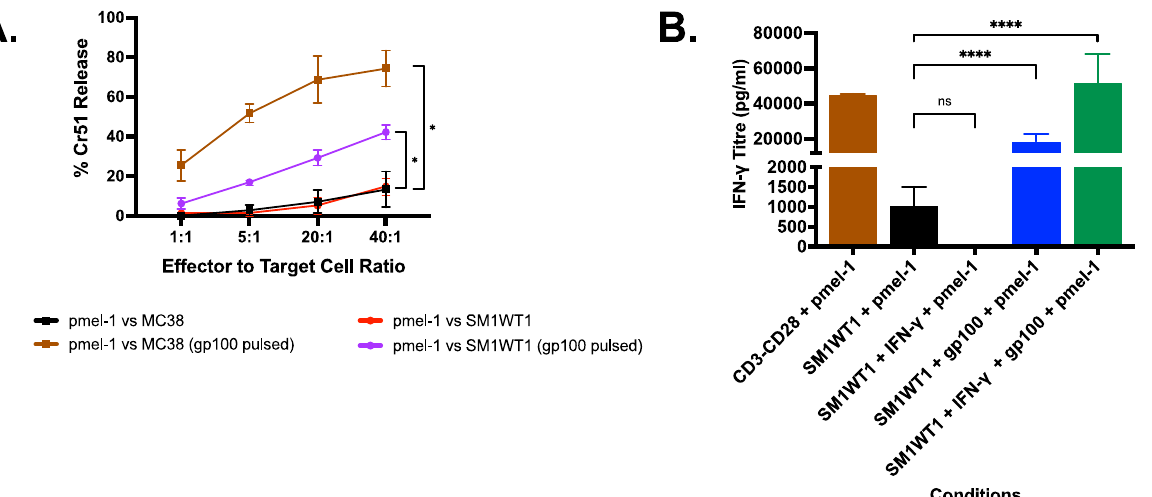
Figure 3. SM1WT1 tumor response to targeted therapy and ACT. ( A ) SM1WT1 tumor volume growth curves of dabraf- enib-trametinib (DT) ± palbociclib (P) and pmel-1 adoptive cell transfer (ACT) with 8 mice per group (mean ± SEM). ( B ) Kaplan–Meier overall survival (OS) curves of data shown in ( A ). Median OS for control, pmel-1, DT, DT + pmel-1, DTP, and DTP + pmel-1 was 21, 21, 29, 31, not attained, and not attained, respectively. OS hazard ratio (HR) for control versus pmel-1 was 1.57, p = 0.32. OS HR for DT versus DT + pmel-1 was 0.995, p > 0.99. OS HR for DTP versus DTP + pmel-1 was